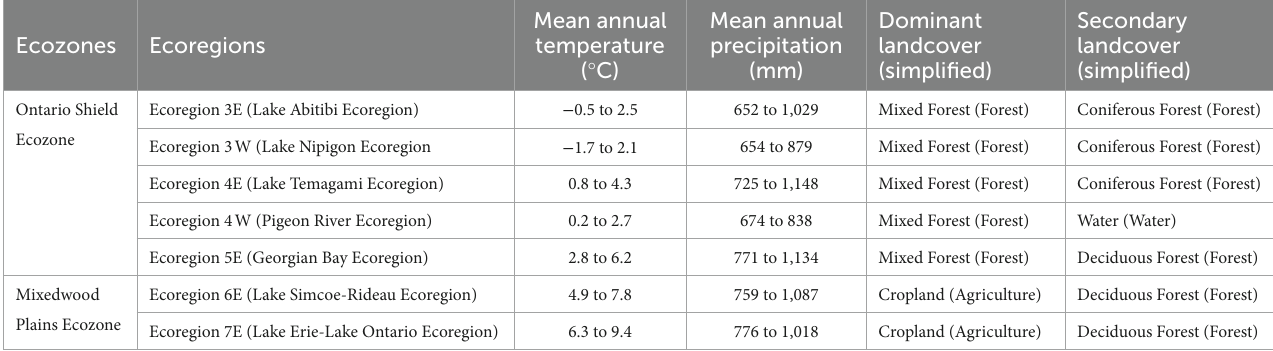
TABLE 1 Ecoregions within the Great Lakes Basin.